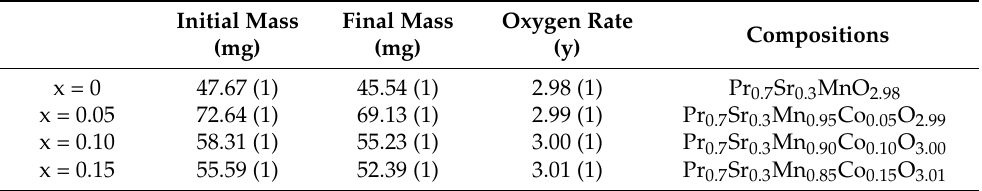
Table 1. Results of thermogravimetric analysis for Pr 0.7 Sr 0.3 Mn ( 1 − x ) Co x O y (x = 0, 0.05, 0.10 and 0.15). The errors are included in parenthesis.